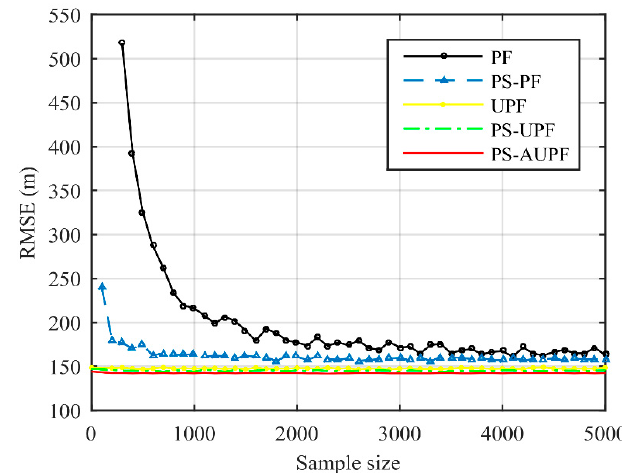
Figure 6. Relationship between sample size and tracking Root Mean Squared Error (RMSE).